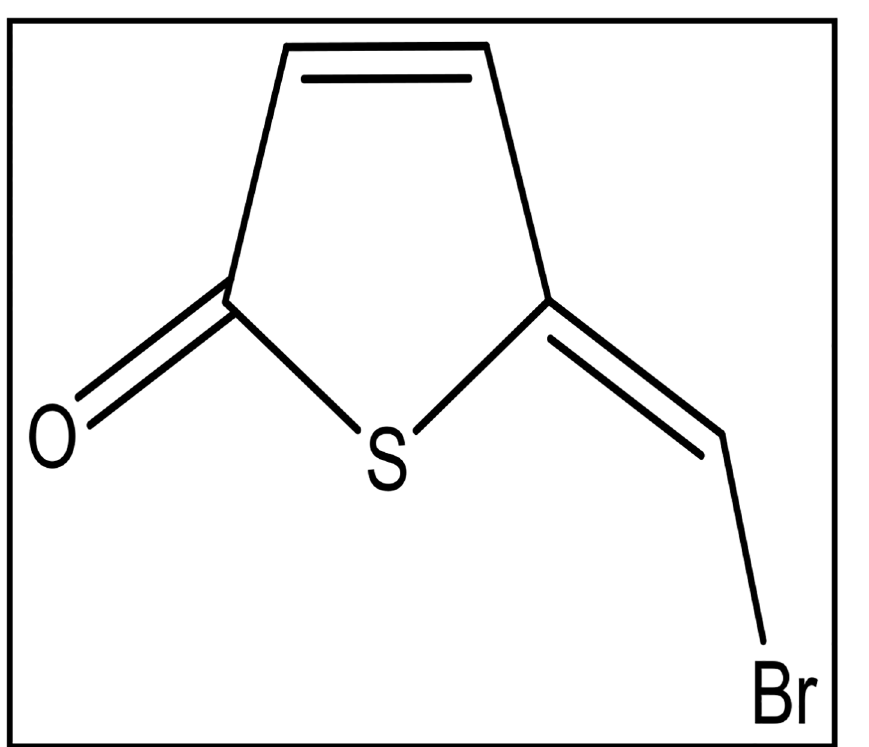
Fig 1. The chemical structure of (Z)-5-(bromomethylene)-thiophene-2(5H)-one (TF101).